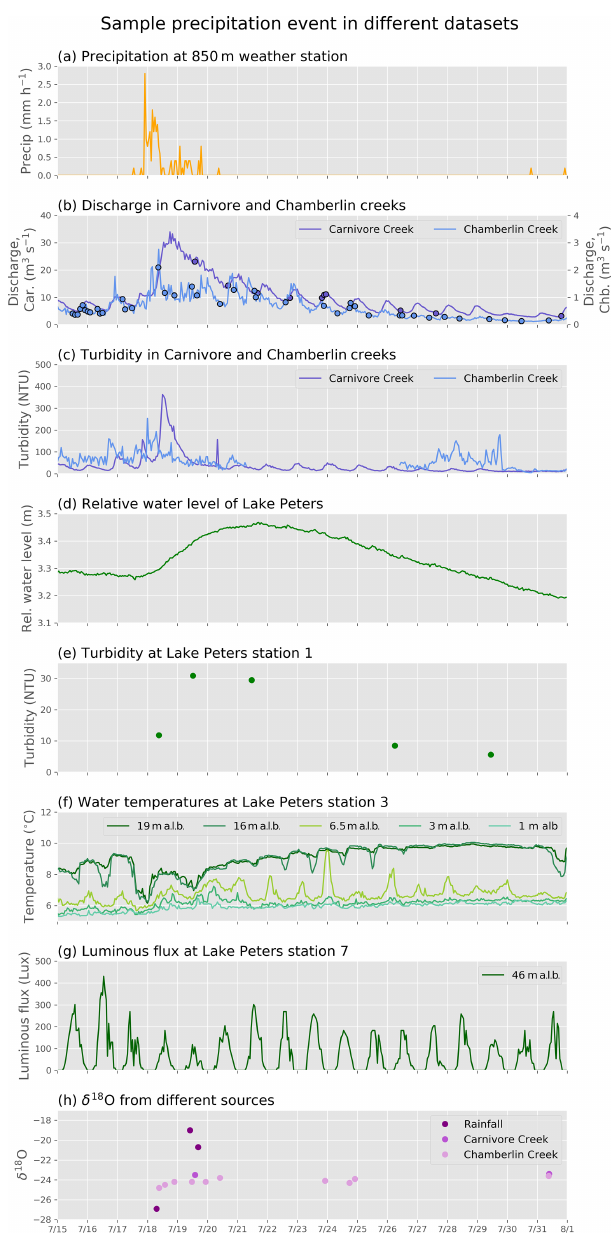
Figure 10. An example of a complementary dataset from Lake Peters observatory, tracing the effects of a precipitation event in July 2015. (a) Rainfall at the 850ma.s.l. station; (b) Carnivore Creek and Chamberlin Creek discharge and (c) turbidity; (d) Lake Peters relative water level; (e) maximum turbidity at Lake Peters station 1; (f) water temperatures at different heights above lake bot- tom (a.l.b.) at Lake Peters station 3; (g) luminous flux at Lake Peters Station 7; and (h) δ 18 O at different sites. To complement panel (e) , a more detailed sample of turbidity data is shown in Fig. 11.